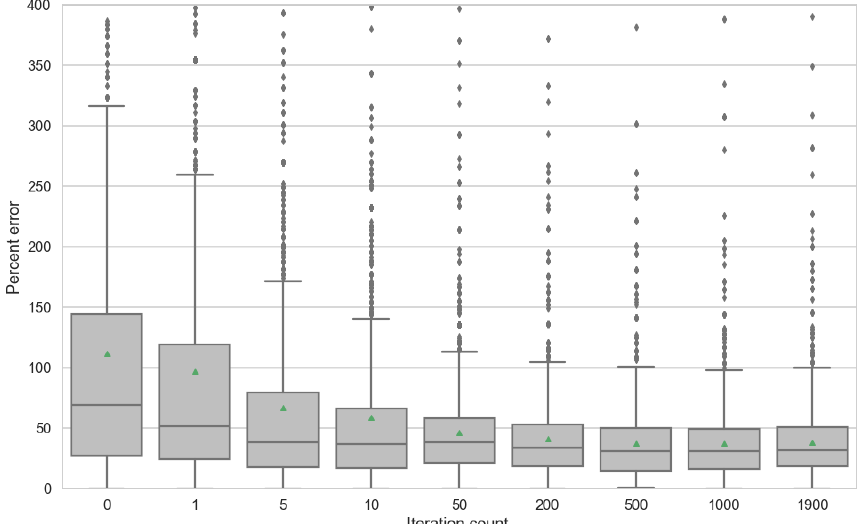
Figure 5. Evolution of the error field between the reference concentration field and the forecast concentration field, in percent, for µ e = 2. At each time step, the error field is computed and the distribution of the absolute errors in each cell, in percent of the cell reference concentration, is depicted in the box plots. Dots outside whiskers represent outliers, and the triangle is the mean.